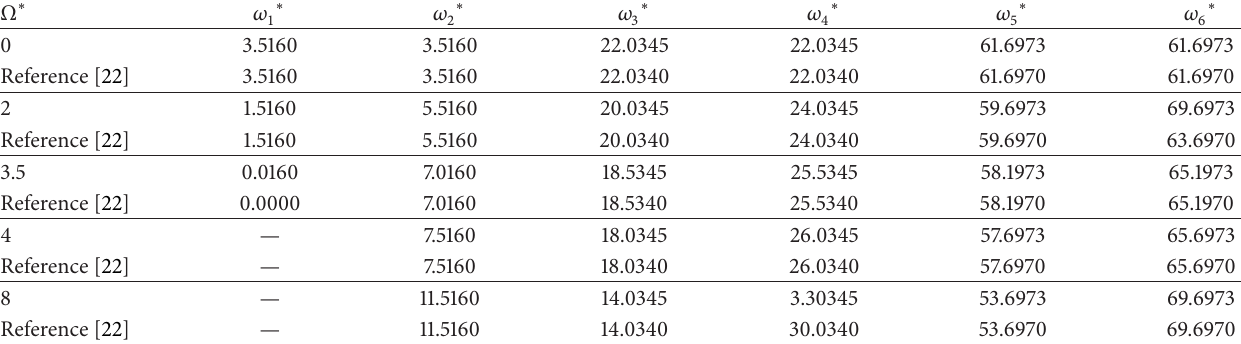
Figure 2: The first three natural frequencies versus rotating speeds of the shaft without SMA and with SMA ( 𝜃 = 30 ∘ ; 𝑇 = 50 ∘ C; 𝑉 𝑠 = 0.24 ; = 0.067 ). 𝜀 0 Table 3: Comparison of the natural frequencies of a cantilever composite shaft without shear